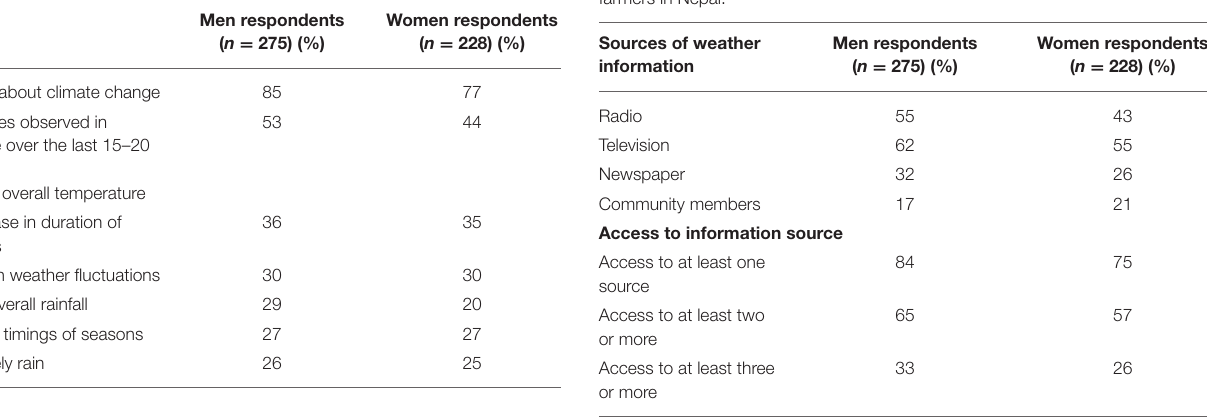
TABLE 1 | Gender disaggregated responses about climate change.